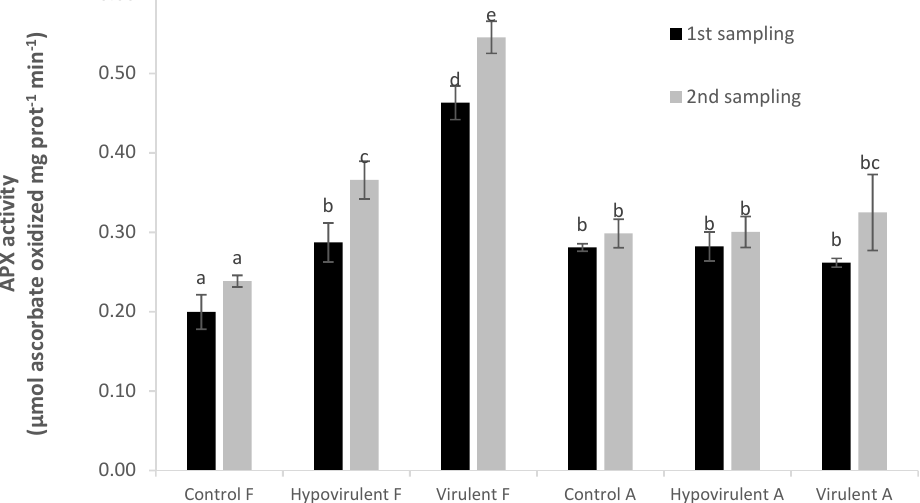
Figure 6. The activity of ascorbate peroxidase 21 and 42 days after the infection. Values are means ± SD, n = 5. Significant differences among samples based on the Tukey-HSD test.